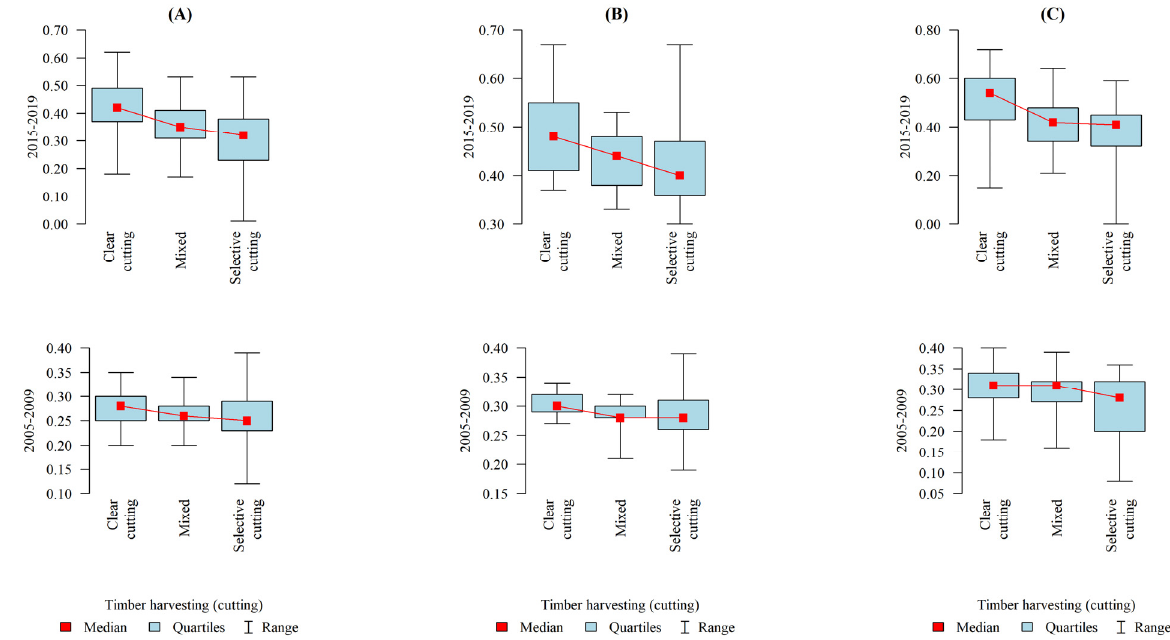
Figure 5. Ranges, medians, and quartiles of synthetic financial indicators 1, 2, and 3 for stand regeneration/felling systems. ( A ) synthetic indicator 1 calculated for the years 2015–2019 and 2005–2009, ( B ) synthetic indicator 2 calculated for the years